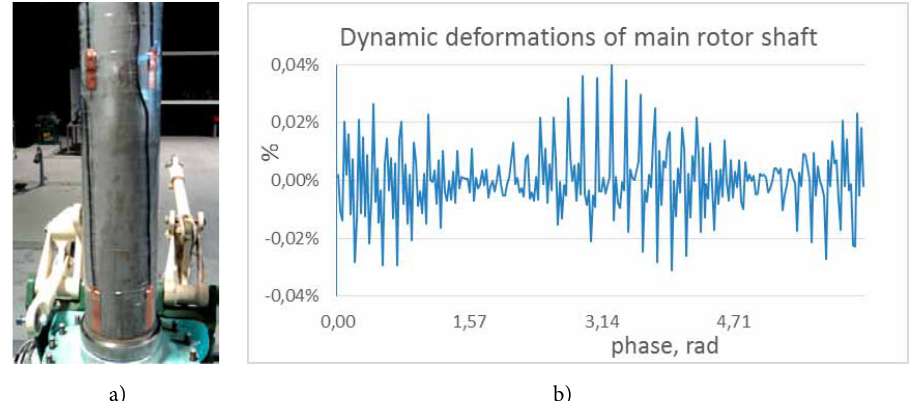
Fig. 9. Deformation transducers on the main rotor shaft (a); the waveform of main rotor deformations in one revolution (b)